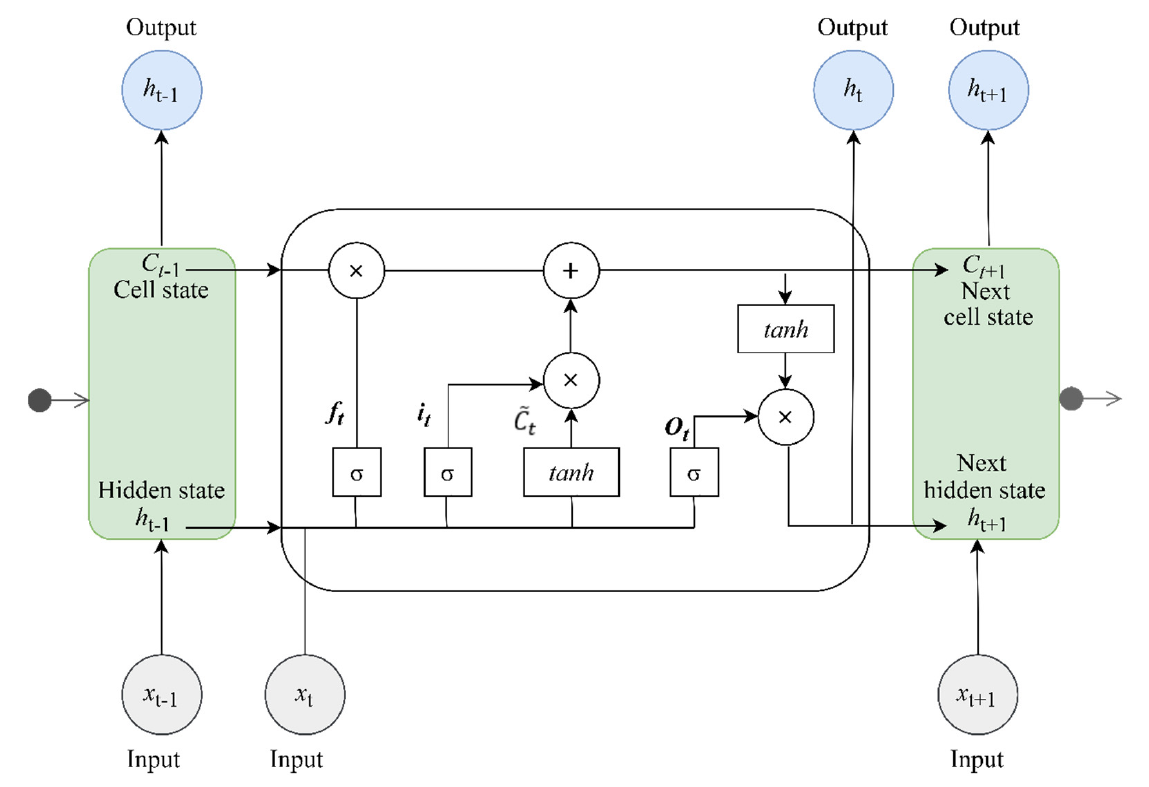
Figure 2. A diagram demonstrating the structure of the LSTM (modified from Li et al. [32]).